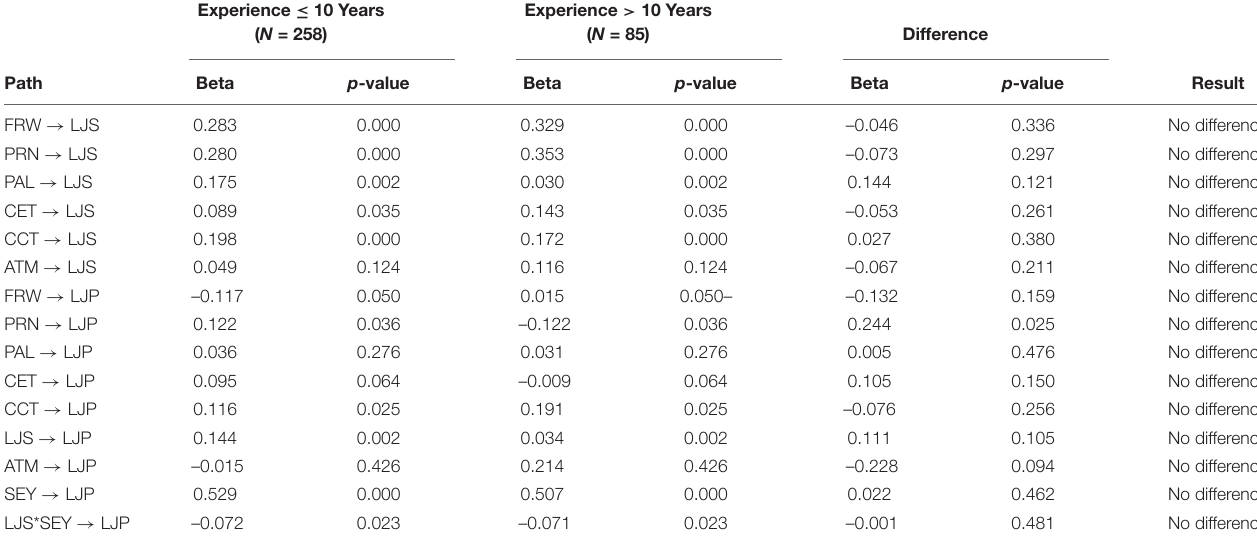
TABLE 6 | Multi-group analysis.